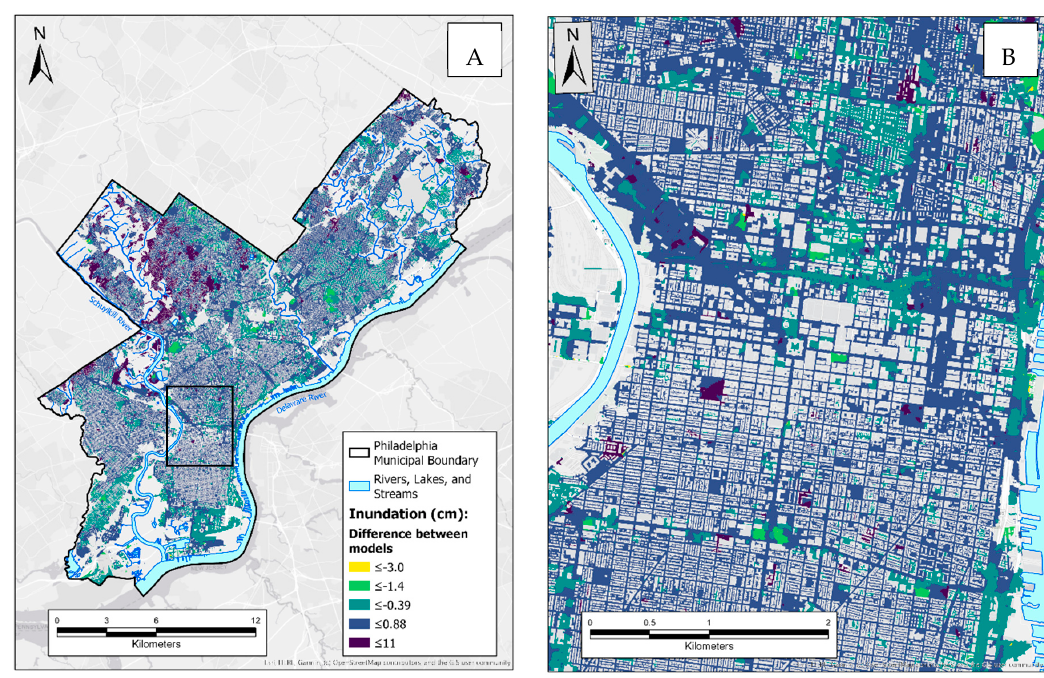
0.88 cm for the majority of subbasins (Figure 4). Water 2020 , 12 , 357